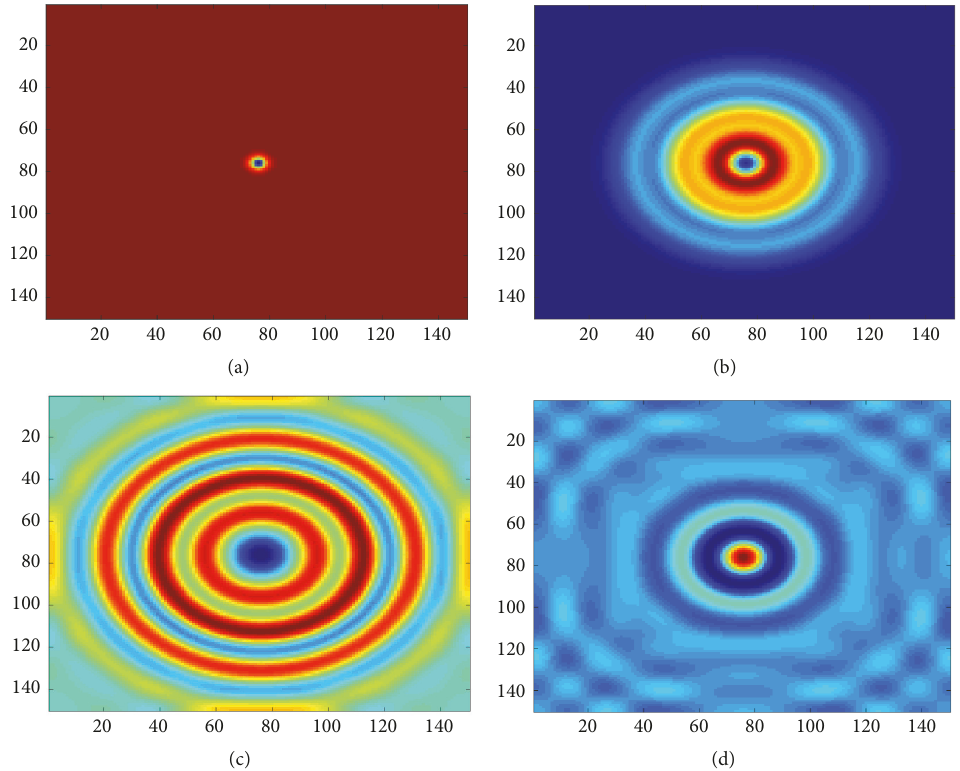
Figure 10: The snapshots of spatial distribution of membrane potential with color scale for neurons in the square array network for 𝑘 = 0.9 and 𝐷 = 5 at (a) 𝑡 = 2 time units, (b) 𝑡 = 75 time units, (c) 𝑡 = 135 time units, and (d) 𝑡 = 300 time